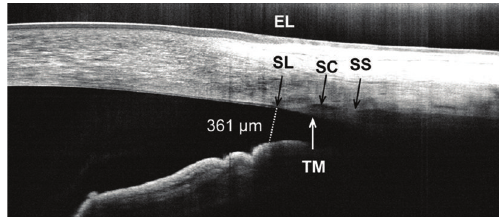
Figure 5: Pre- and postlaser peripheral iridotomy OCT images of an eye with narrow angles. (a) Preoperative image of the nasal angle with frame averaging. The short distance between the trabecular meshwork (TM) and the iris indicates a narrow, potentially occluded angle. The AOD-SL (dotted line) measured 120 µ m. An aqueous collector vein and the Schlemm’s canal (SC) are also visible. (b) Frame-averaged cross-sectional OCT image of the same angle following laser peripheral iridotomy. The procedure nearly doubled the AOD-SL (dotted line) to 220 µ m, reprinted with permission from SLACK Incorporated: Huang D, Duker JS, Fujimoto JG, Lumbroso B, Schuman JS, Weinreb RN. Imaging the Eye from Front to Back with RTVue Fourier-Domain Optical Coherence Tomography. Thorofare, NJ: SLACK Incorporated;